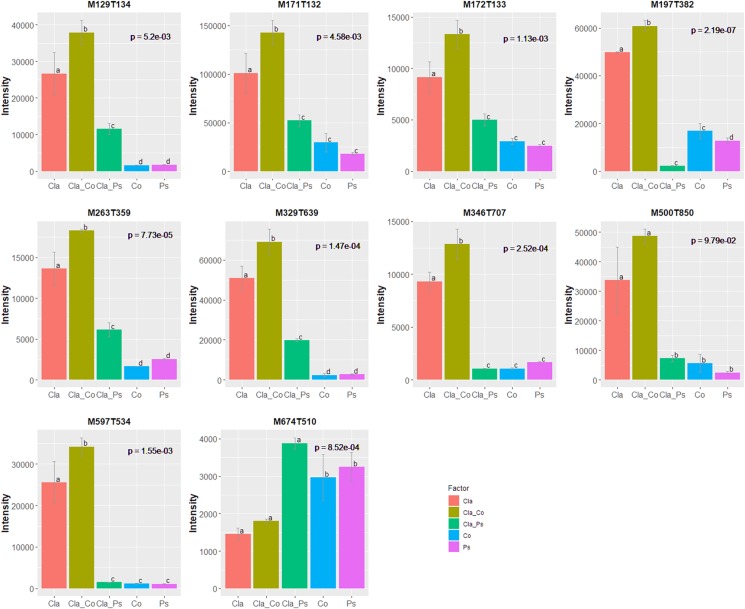
10 variables displaying a correlation with the predicted luminescence response above 0.75 and a higher mean value in co-culture conditions compared to other mono-culture conditions or the alternate co-culture condition. p-Values coming from ANOVA are stringently corrected for the false discovery rate when considering the initial set of 4221 variables. Multiple comparisons of means used the Student-Newman-Keuls test.